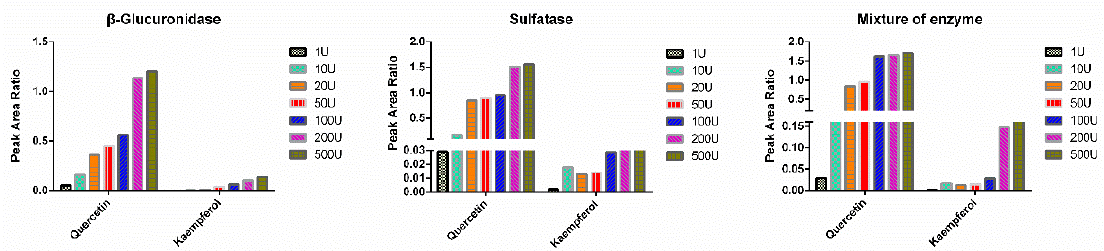
Figure 1. Peak area ratio of analytes with different volume of hydrolase.